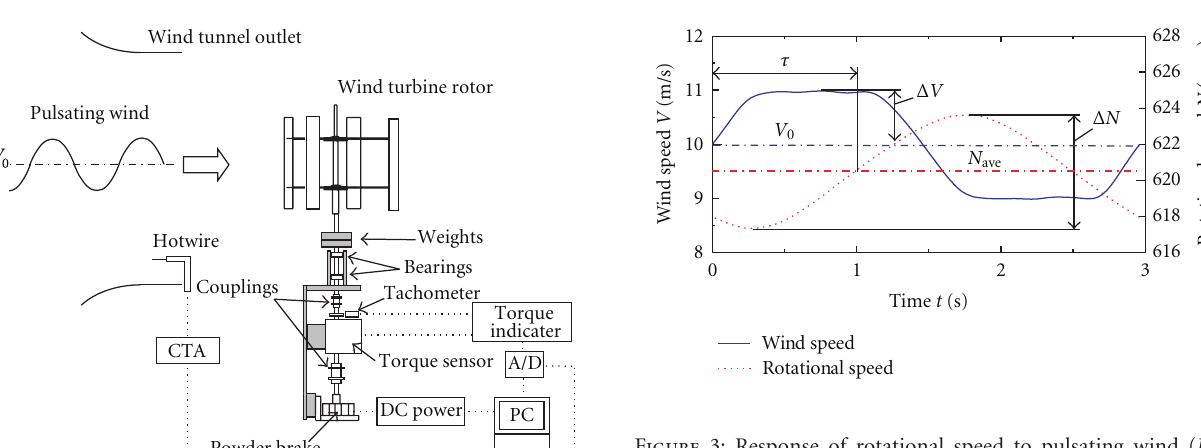
Figure 3: Response of rotational speed to pulsating wind ( I = 0 . 1kgm 2 , T = 3s, Δ V = 1m/s).